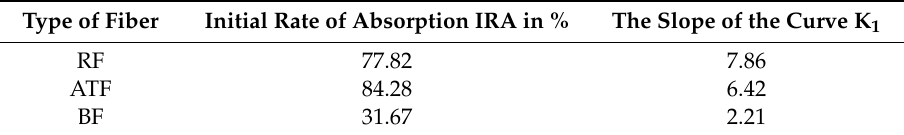
Table 2. Data results from water absorption test in logarithmic law.